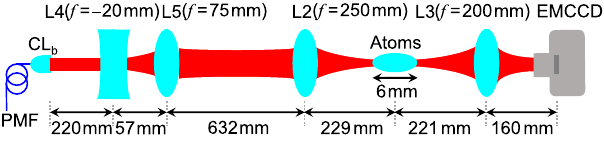
Fig. 3 Sketch of key elements for taking images of the probe beam. Values of f indicate the focal lengths of lenses. PMF polarization-maintained optical fi ber; CL b : collimation lenses, L2 and L3: lenses, EMCCD electron- multiplying charge-coupled device camera (Andor DL-604M-OEM). The probe beam coming out of CL b was collimated and had the e − 1 full width of 0.92 mm. We adjusted the separation between L4 and L5 such that the beam was focused on nearly the center of the atomic cloud by L2, and had the width of 39 μ m at the focal point.